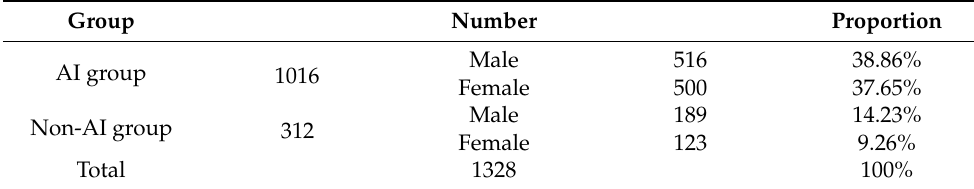
Table 1. Details of “whether to use AI for